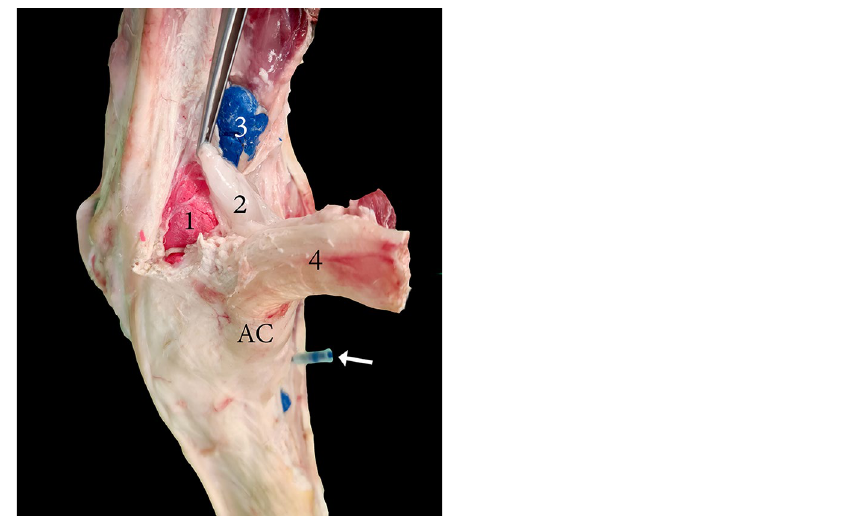
Figure 6. Palmar view of the left carpal joint showing 1, the lateropalmar pouch of the radiocarpal joint; 2, the subtendinous bursa; 3, inadvertent communication created with the tendon sheath of the deep digit flexor muscle (DDF); 4, extensor carpi ulnaris; AC, accessory carpal bone. The white arrow indicates the palmar injection approach to the carpometacarpal joint, which caused an inadvertent communication between the joint cavity and tendon sheath of the DDF.